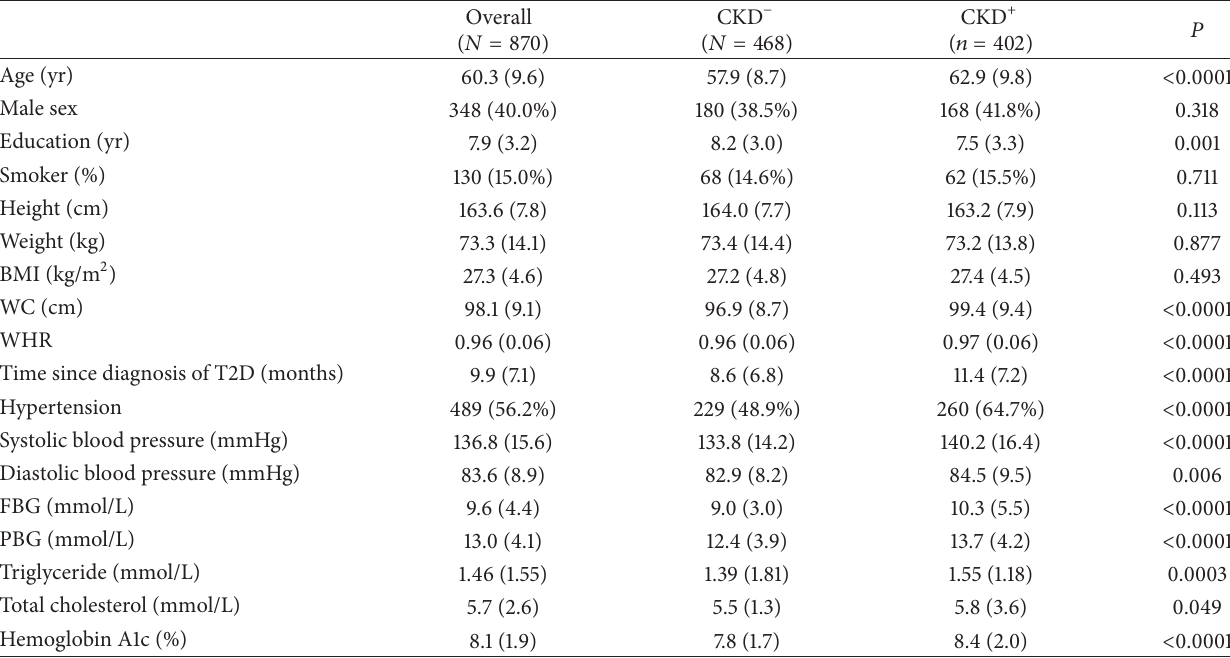
Table 1: Characteristics of the study patients.